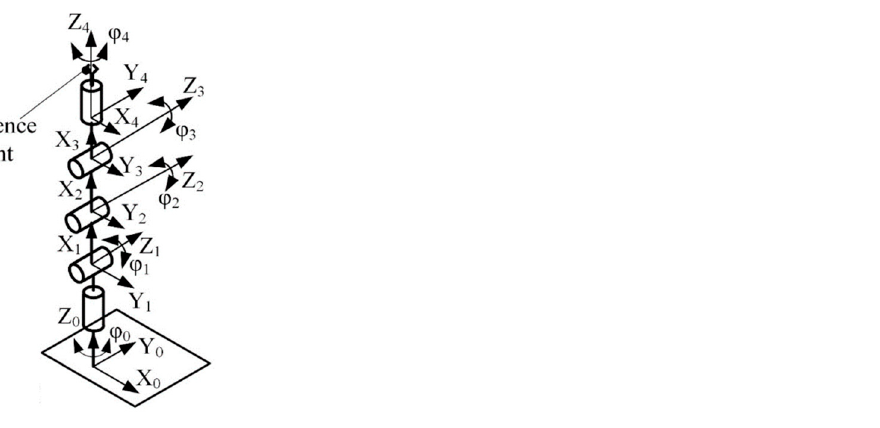
Figure 4. The start position of the robot for the measurements of separate joint impact to robot vi- brations.